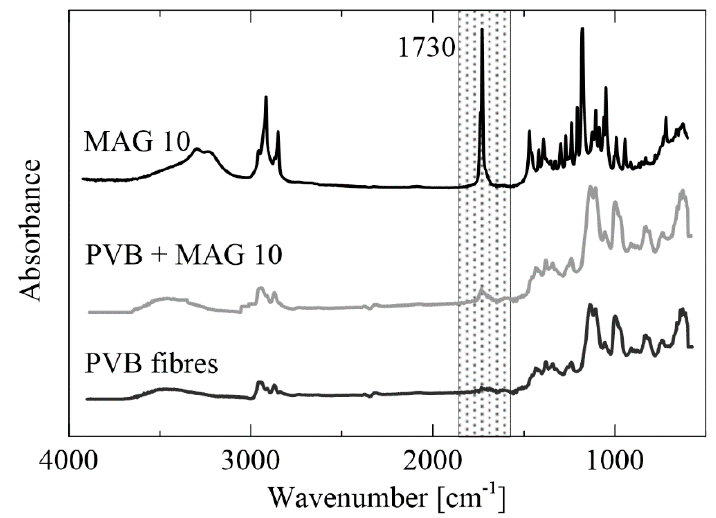
Figure 6. Fourier transform infrared spectroscopy (FTIR)-ATR spectra of the neat PVB and PVB modified with MAG 10.